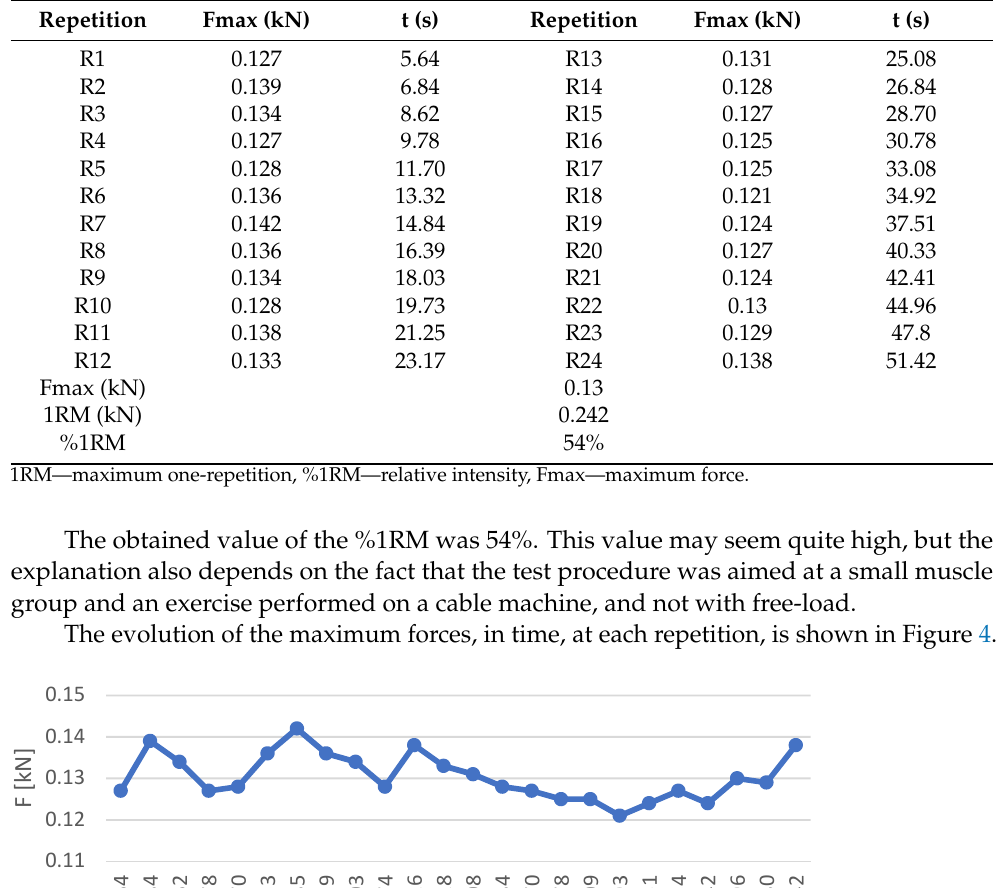
Table 2. Maximum forces per repetition—10 kg load.